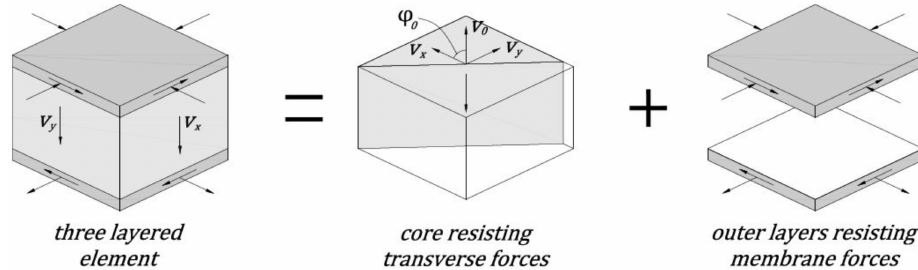
Figure 4. The concept of slab elements divided into three layers; see [40] for details.